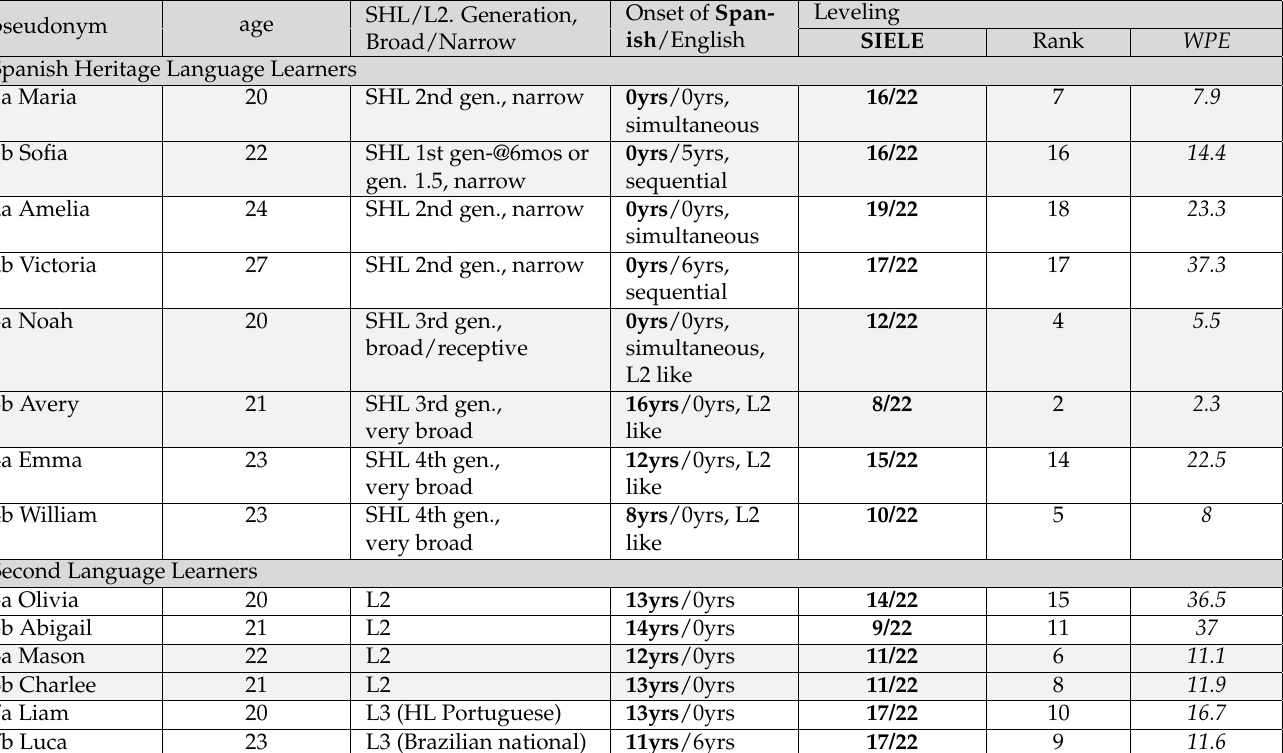
Table 1. The Collaborative pairs with pseudonyms. The numbers and shading indicate the